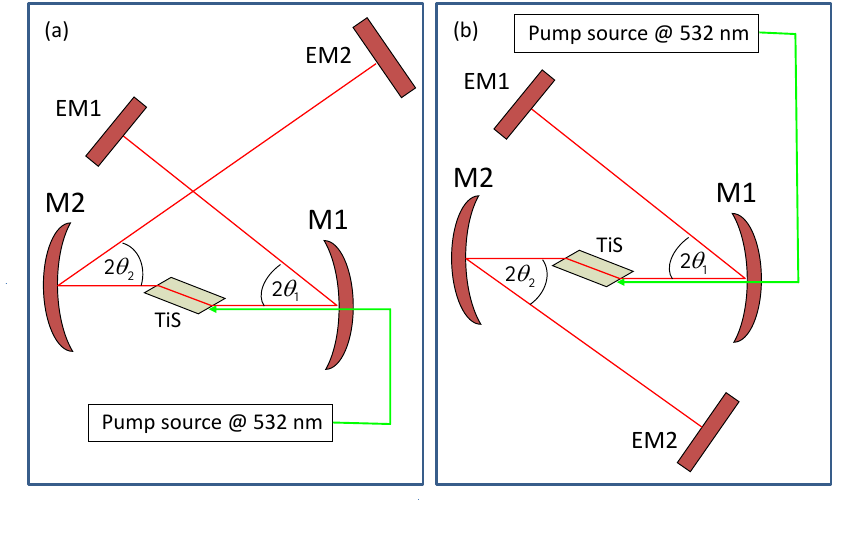
Figure 1. Standard ( a ) X-shaped and ( b ) Z-shaped configurations of a linear Ti:sapphire cavity with a Brewster-cut crystal. Both configurations work equally well. The folding angles, θ and θ , allow for the compensation of the astigmatism from the Brewster crystal, 1 2 as discussed in Section